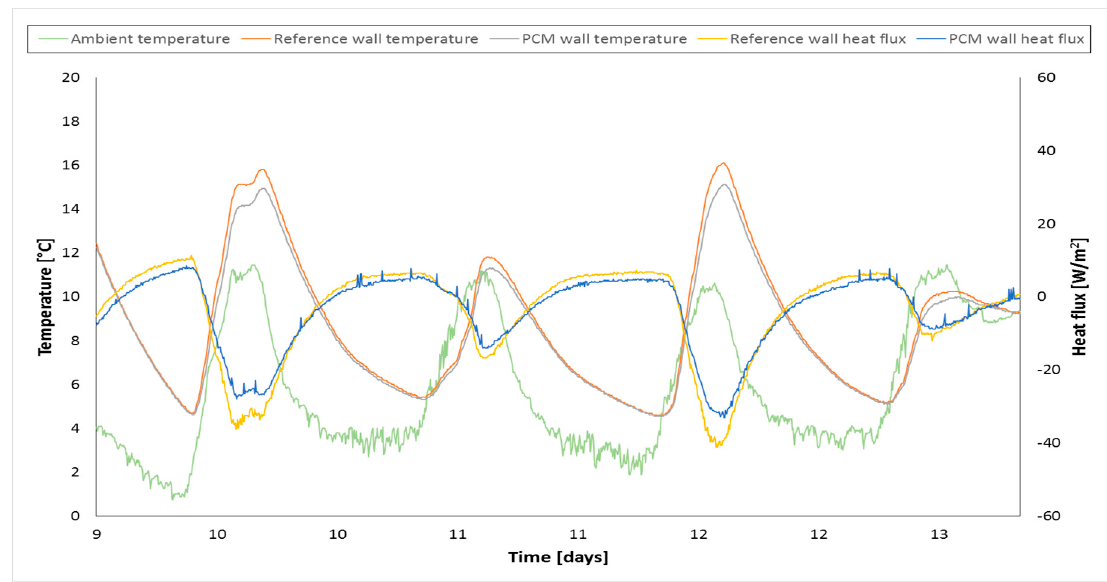
Figure 6. Comparison between interior surface south wall temperatures, outdoor temperature and heat flux through the south wall for both cubicles. Winter (December).